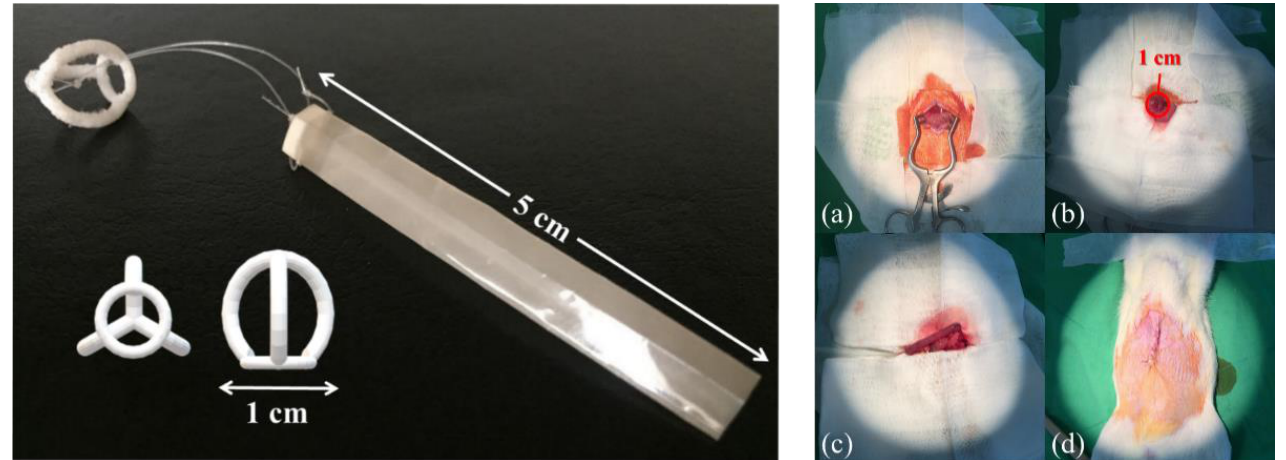
Figure 2. ( Left side ) PVDF film intestinal sleeve implant and, ( Right side ( a – d )) surgical procedure of film intestinal sleeve implantation in SD rats.